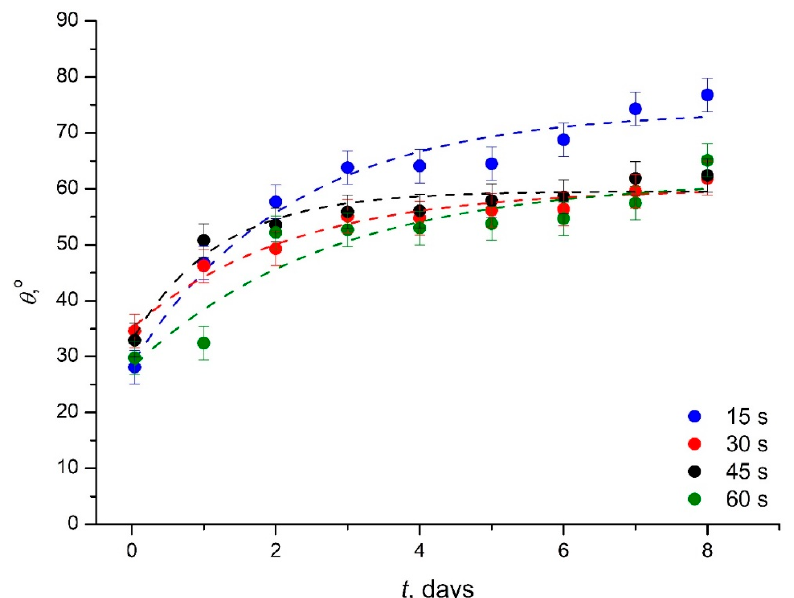
Figure 5. Kinetics of the hydrophobic recovery of PVC following Corona plasma treatment is shown. Blue circles correspond to the 15 s treatment; red circles correspond to the 30 s treatment; black circles correspond to the 45 s treatment; and green circles correspond to the 60 s treatment. The dashed line corresponds to the exponential fitting with Equation (5). The parameters of fitting are supplied in Table 2.